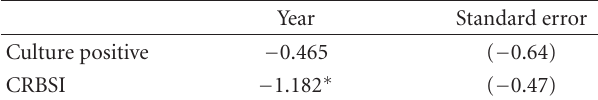
Table 2: Regression analysis using ordinary least squares (OLS) expressing the decline in culture-positive and CRBSI rates per year over 12